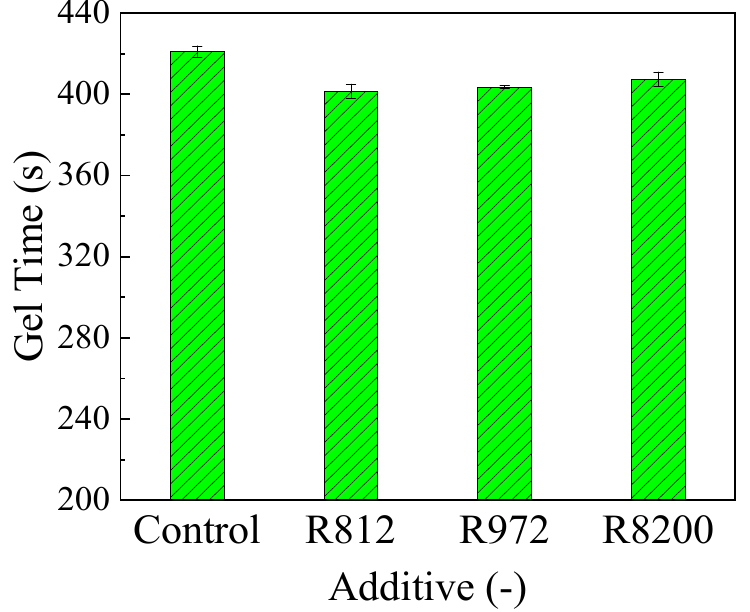
Figure 9. Gel time of polyester powder samples.